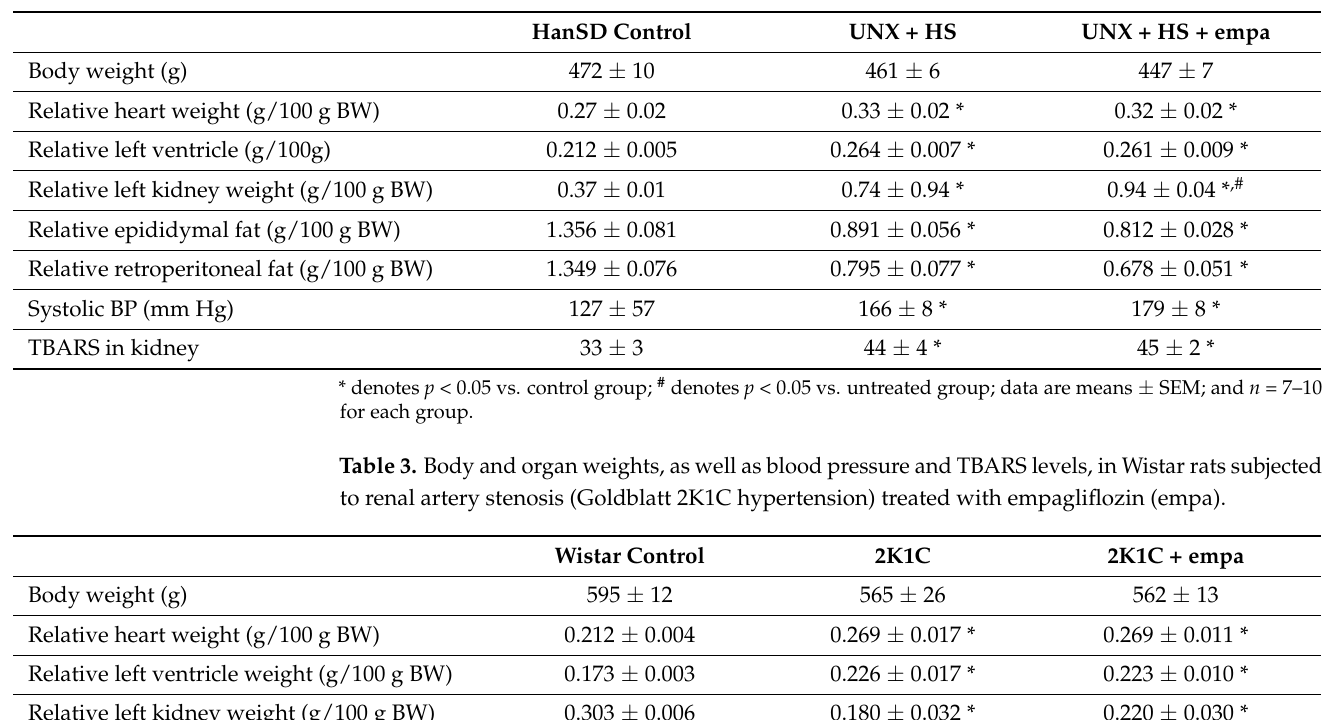
Table 2. Body and organ weights as well as blood pressure and TBARS levels in uninephrectomized